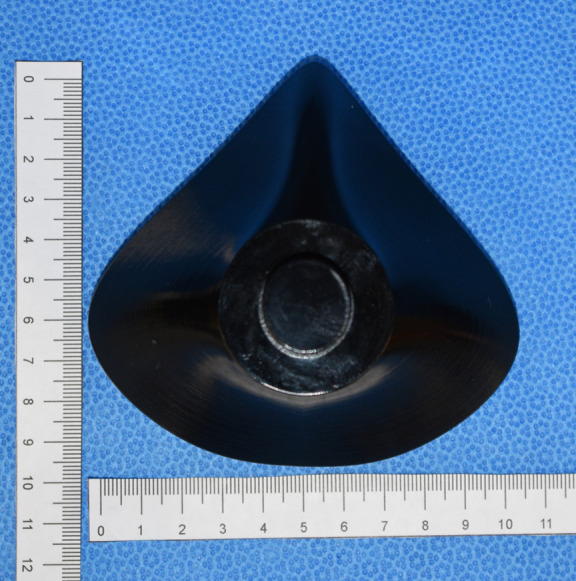
3D printed mold middle component is shown.